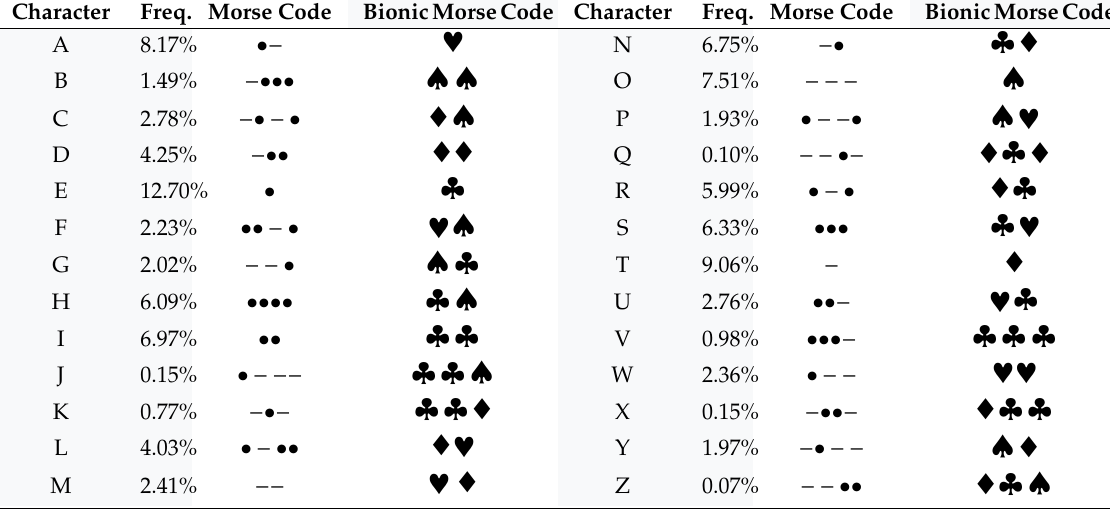
Figure 1. Humpback whale song phrase in ( a ) time and ( b ) frequency domain.